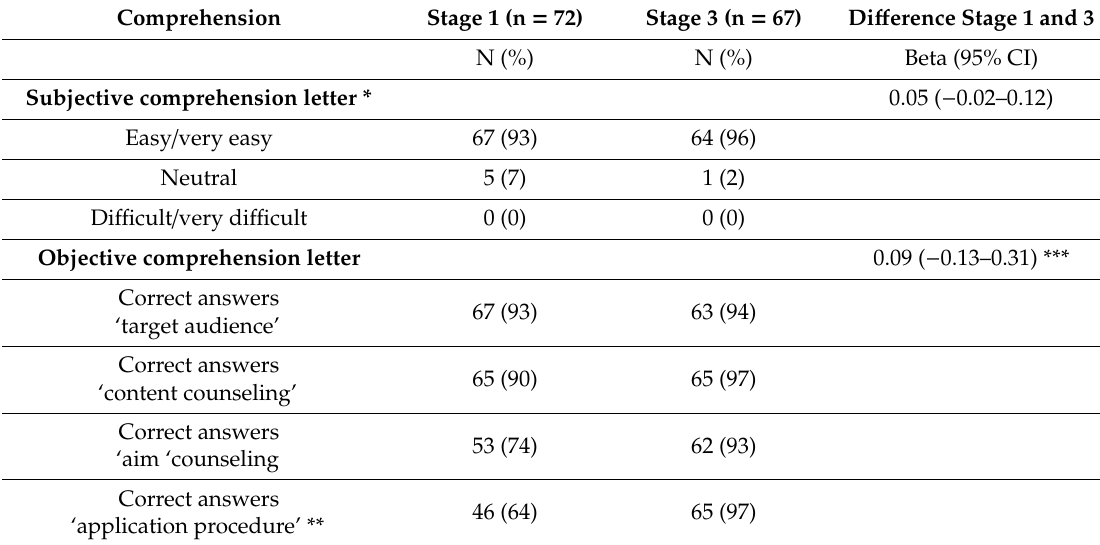
Table 6. Di ff erences in comprehension between stage 1 and 3 (n = 139).